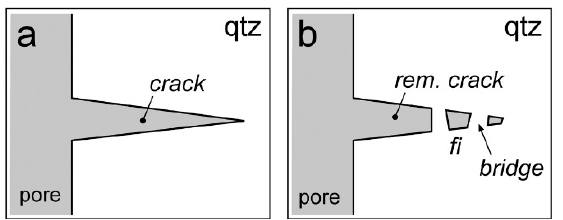
Figure 3. Schematic of the crack-healing process in quartz ( qtz ) with the formation of quartz bridges within the crack and the formation of fluid inclusions ( fi ); shaded areas are filled with fluid: ( a ) open crack; ( b ) partly-healed crack ( rem is the remaining open part of the crack).